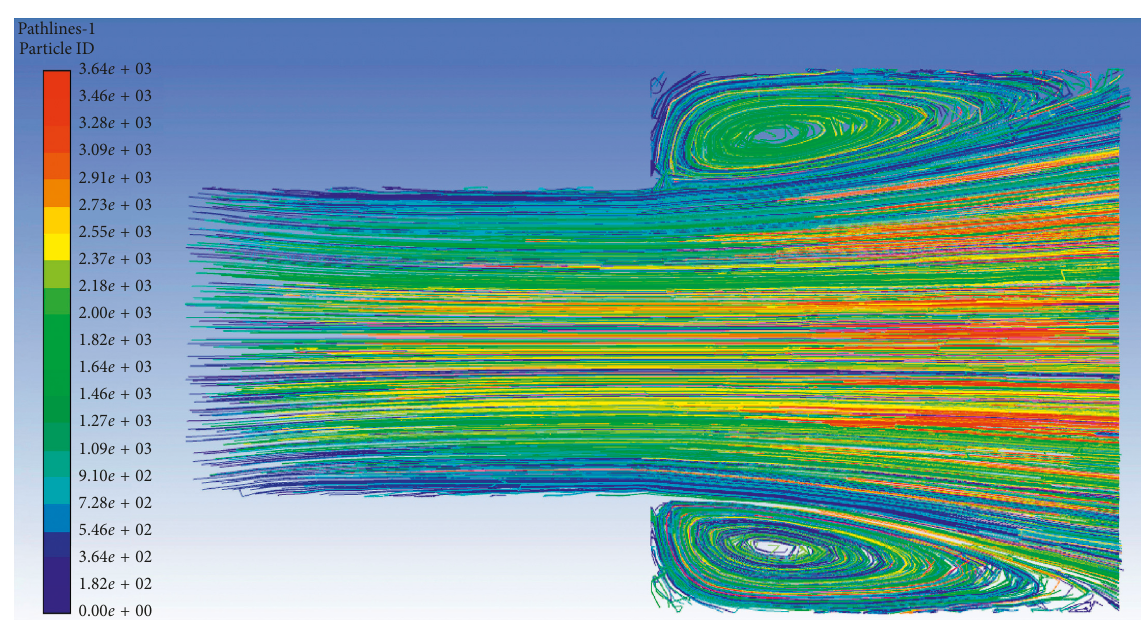
Figure 10: Sudden extension ratio is